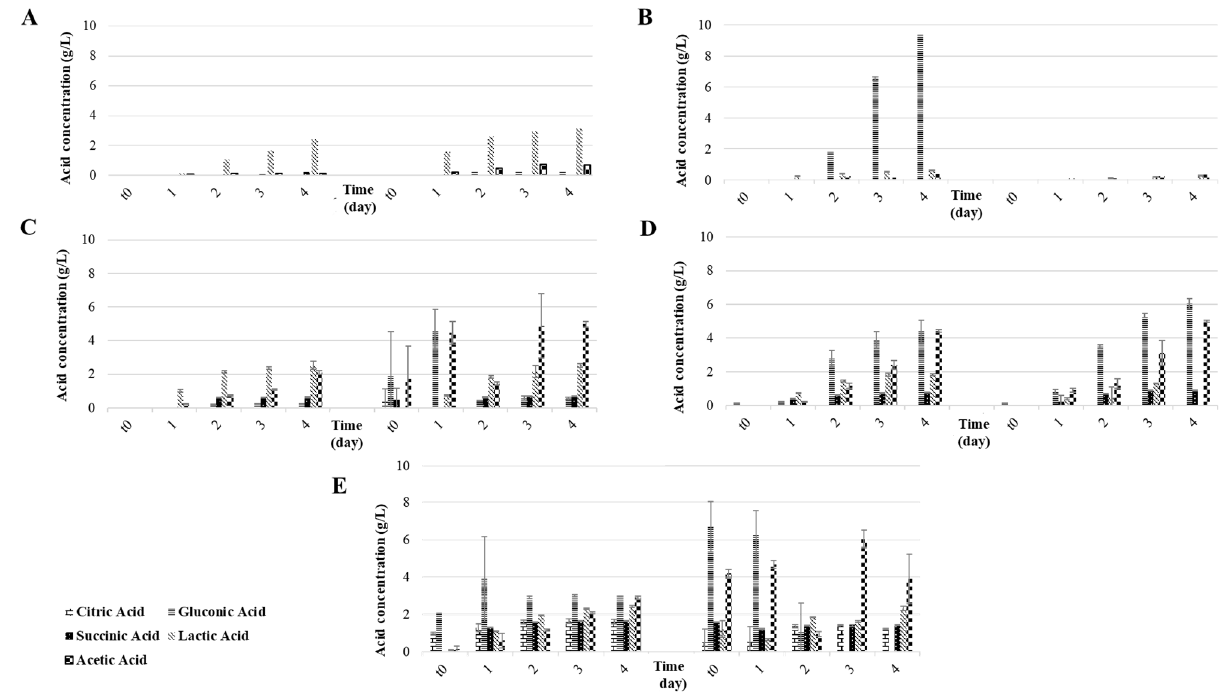
Figure 2. Organic acid development in fruit water kefirs. ( A ) Sucrose, yeast extract and peptone, ( B ) sucrose, ( C ) apple, ( D ) raisin, ( E ) fig. Microbial isolation from the grains and fermentate of the fruit water kefirs provided Table 1. Characteristics of fruit water kefir fermentations. some insight into the observed organic acid profiles (Table 2). Acetic acid bacteria of the genera Acetobacter and Gluconobacter were dominant isolates from all fruit water kefirs. Two Acetobacter species were found in the apple and raisin water kefirs, and three in the fig water kefir; A. fabarum was common to all, a species commonly found in other studies